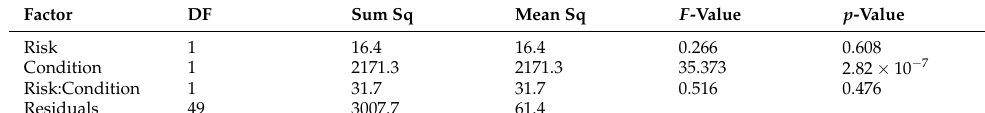
Table 1. The summary table for ANOVA results for the number of checks. DF is degrees of freedom, Sum Sq contains values for the sum of squares, Mean Sq are mean squares, and F - and p -values are respective ANOVA statistics values.